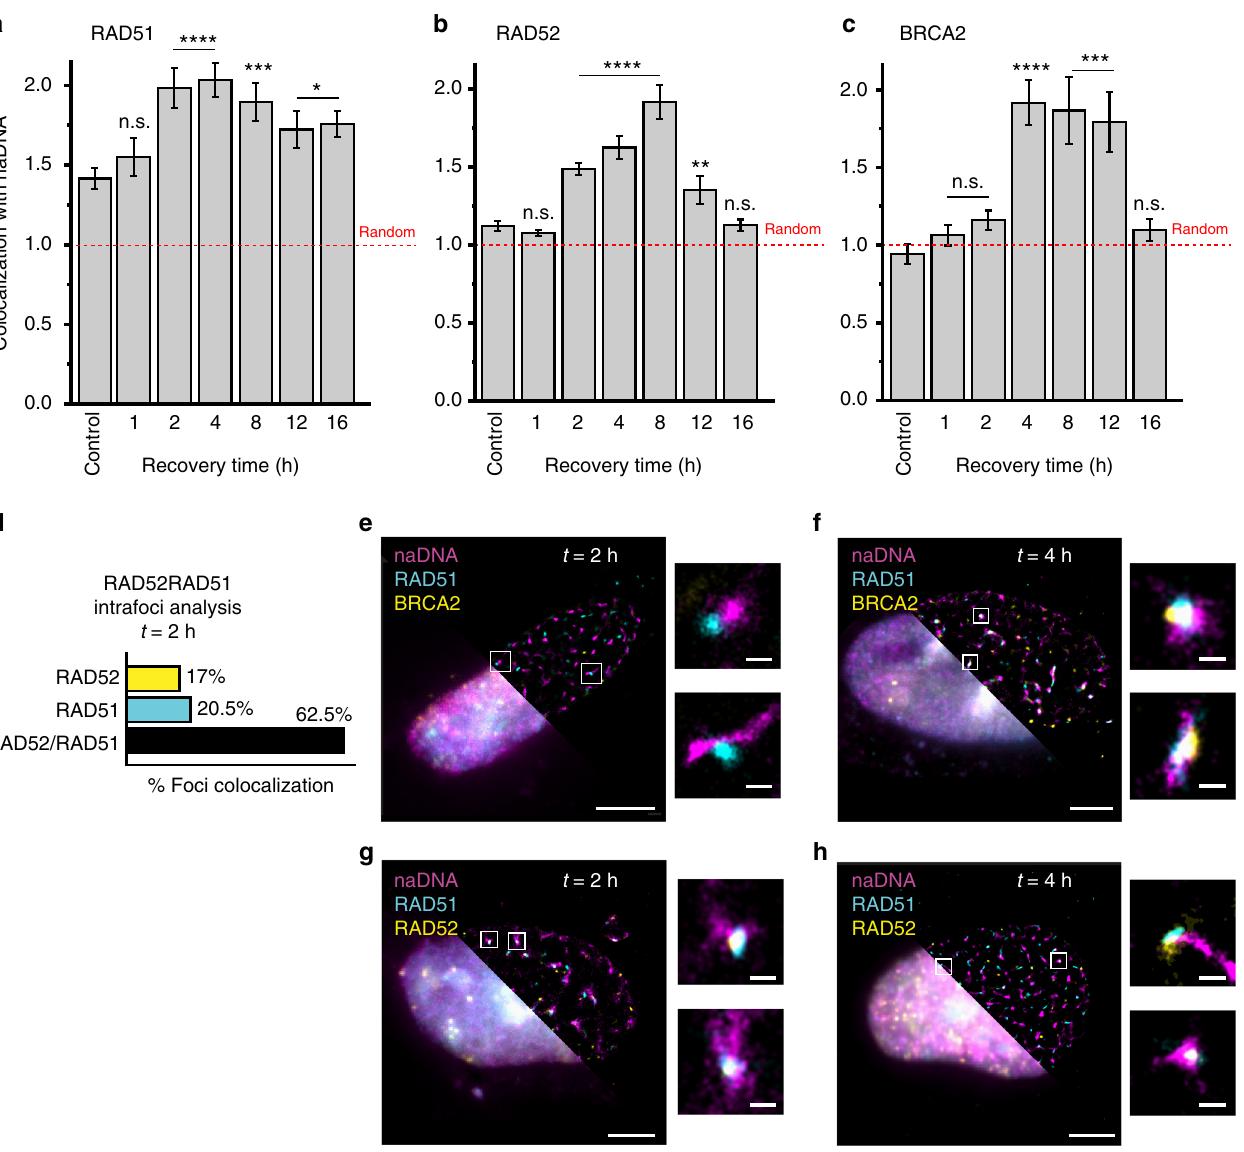
Fig. 2 RAD52 colocalizes with RAD51 at damage sites prior to BRCA2 colocalization. a – c Kinetics of a RAD51, b RAD52, and c BRCA2 colocalization throughout repair (over 16 h of recovery). For complete N values, see Supplementary Table 1. Values were calculated using the Monte Carlo randomization method as described. This allowed the detected number/area of colocalization for each cell to be normalized to the predicted number/area of colocalization in a random simulation of the same cellular image. As plotted here: 1 indicates random overlap (shown as red dashed line), whereas 2 indicates double the number/area of overlaps as expected based on the randomized model. Colocalization in undamaged control cells also shown. Error bars represent mean ± s.e.m. Student ’ s t test for signi fi cance between control and damage levels. n.s. p > 0.05, * p < 0.05, ** p < 0.01, *** p < 0.001, **** p < 0.0001. d Analysis of the colocalization of RAD51 and RAD52 at repair foci 2 h after damage. For complete N values, see Supplementary Table 2. e – h Representative whole-cell super-resolution (top right) and diffraction limited (bottom left) images of cells stained for e , f naDNA, RAD51, and BRCA2 or g , h naDNA, RAD51, and RAD52 at e , g 2 h of recovery or f , h 4 h of recovery. Zoomed in images show representative protein colocalization at naDNA foci. Whole-cell image scale bar = 3 μ m, zoomed sections = 250